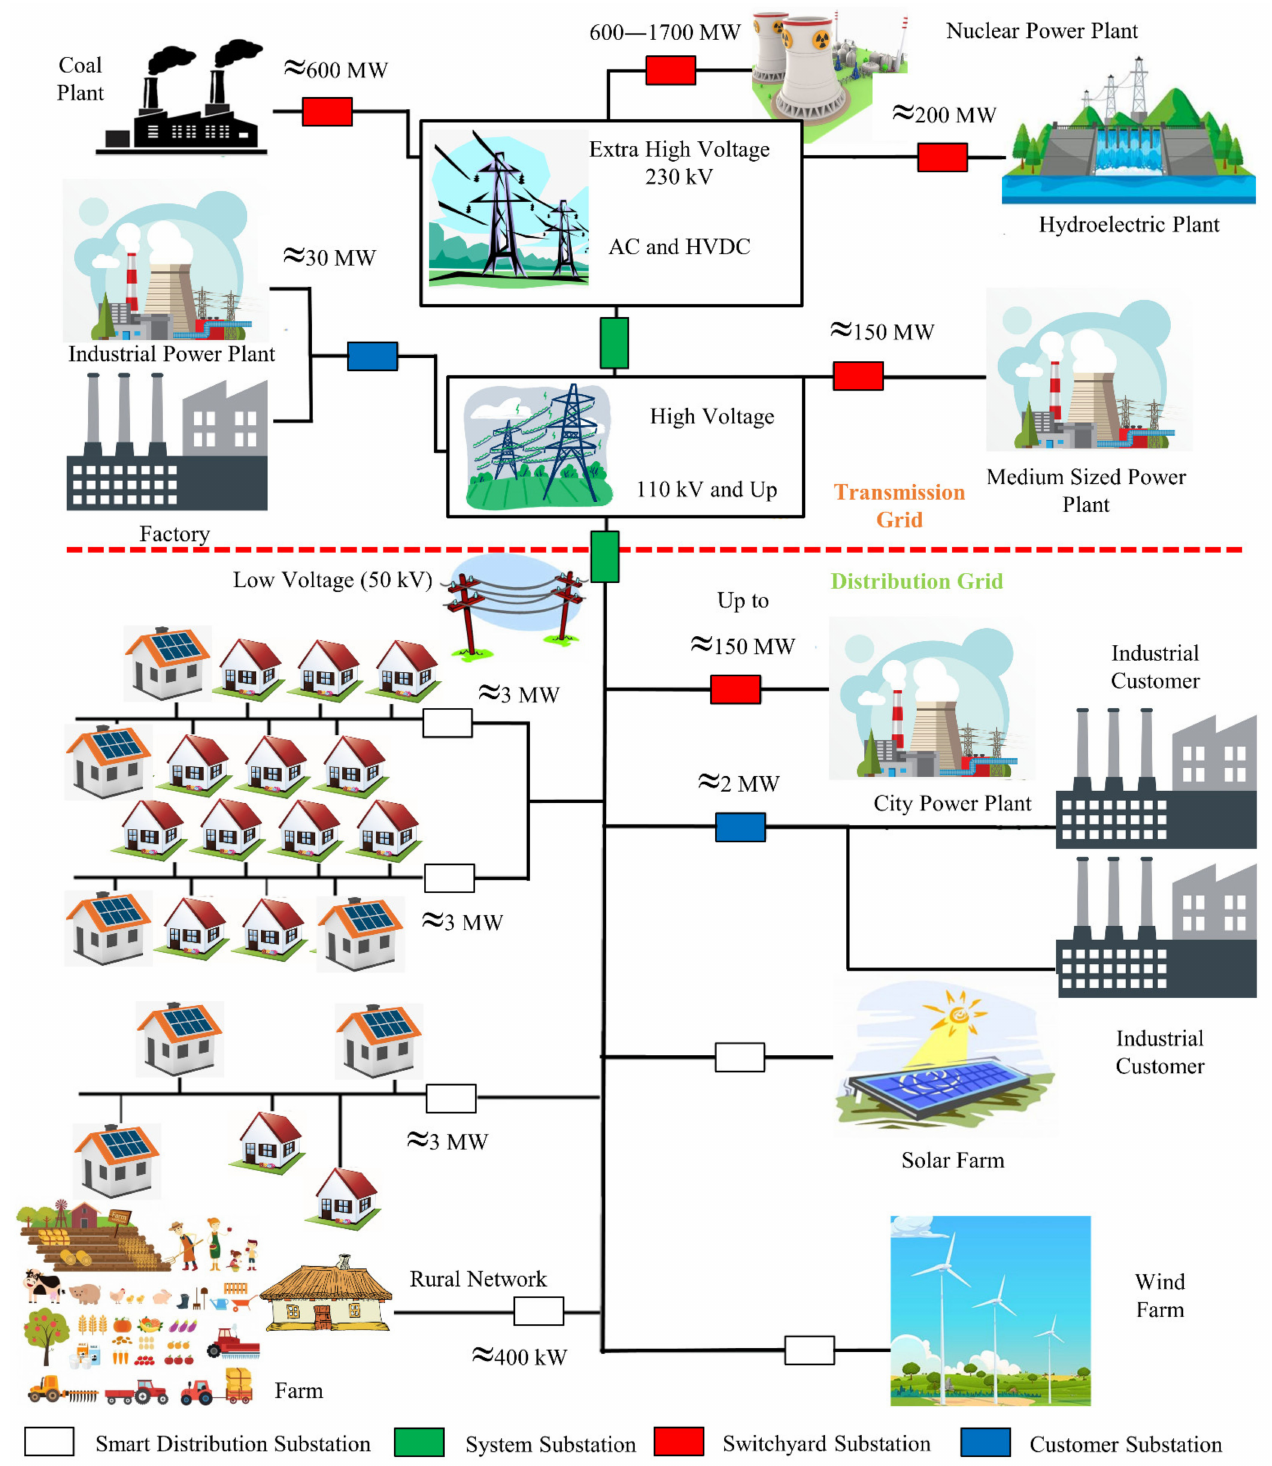
Figure 4. Prospective power network of Bangladesh after integrating renewable energy